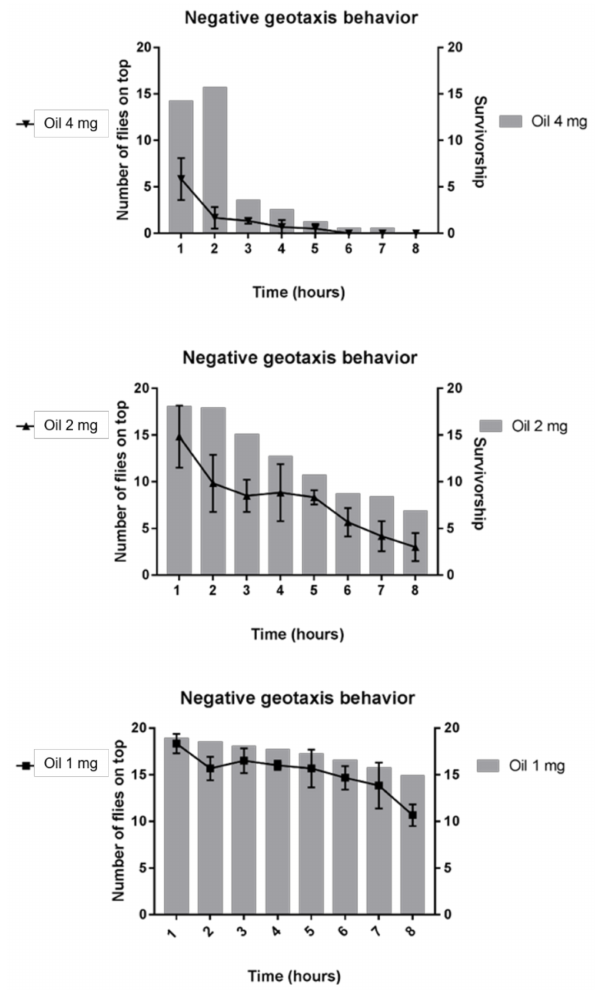
Figure 8. Relationship between alive flies and alterations in